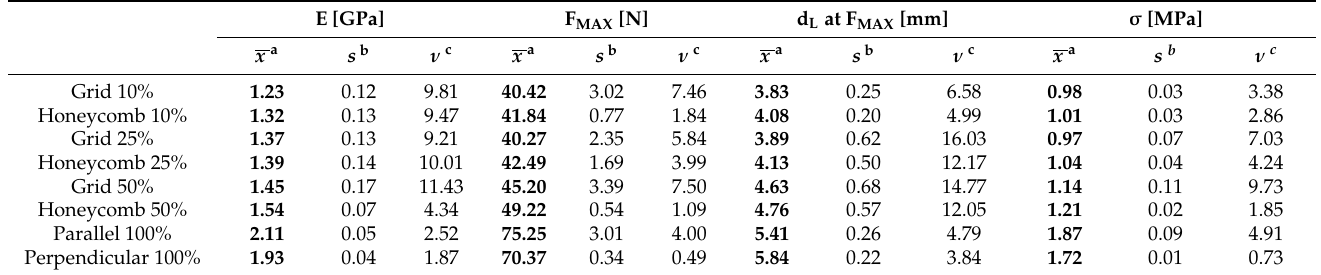
a Arithmetic average. b Standard deviation. c Percentage relative deviation.